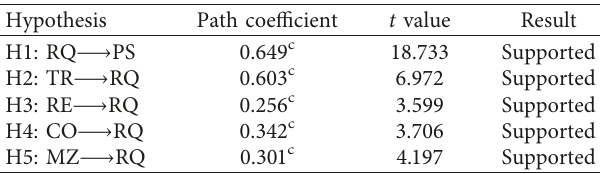
Figure 2: Results of PLS analysis for the structural model. Table 5: Result of hypothesis